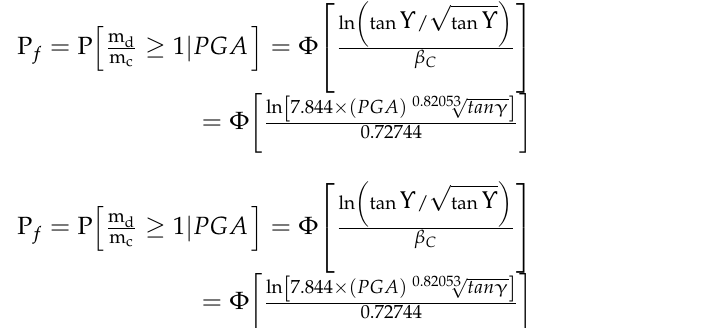
Figure 8. Logarithmic regression relationship: ( a ) tan γ and PGA(g); ( b ) d 0 and PGA (g).